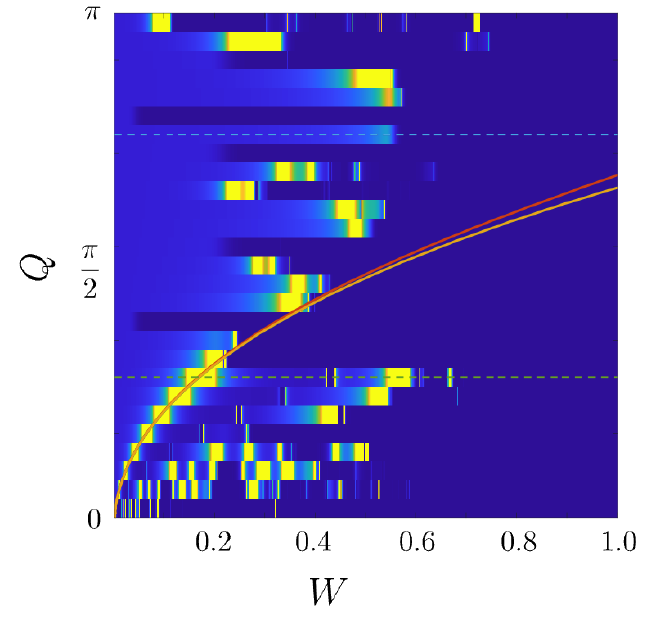
(cid:81) m ± ) com- p / d